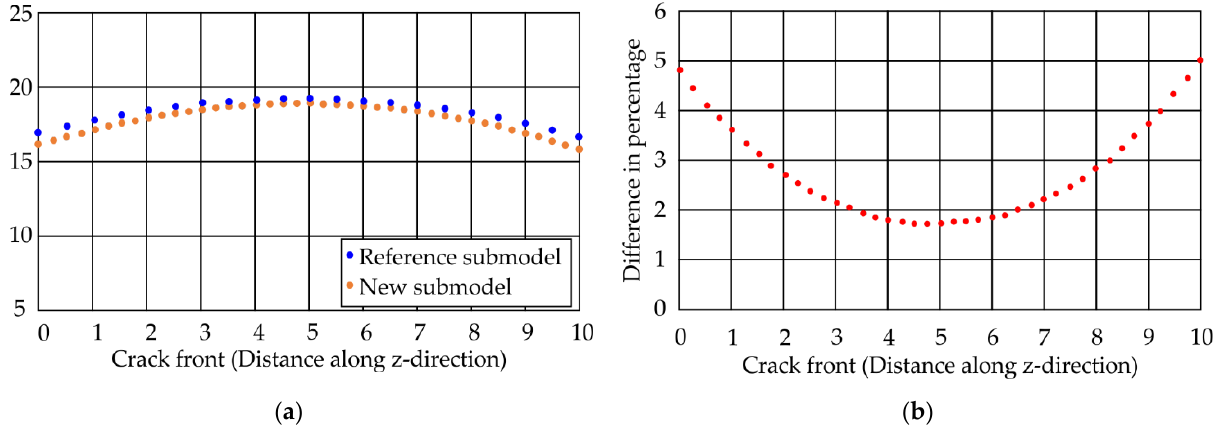
Figure 11. Stress intensity factors calculated by Adapcrack3D for CT specimen and the difference between the results: ( a ). Stress intensity factors along the crack front for Mode I loading of the reference submodel and the new submodel; ( b ) Difference in percentage between the values in Figure 11a along the crack front.